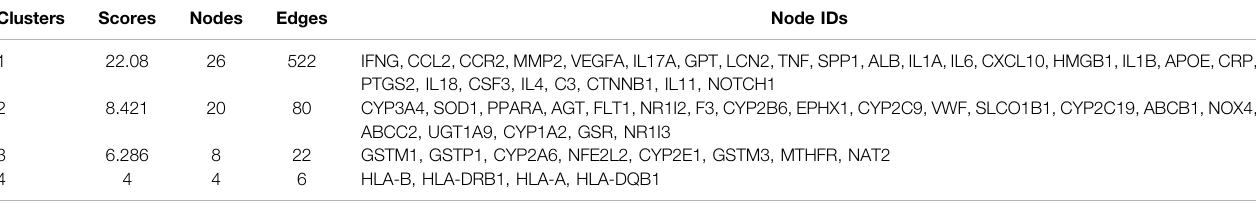
TABLE 1 | MCODE clusters and their associated genes from DPTS-induced liver injury regulatory network. Clusters